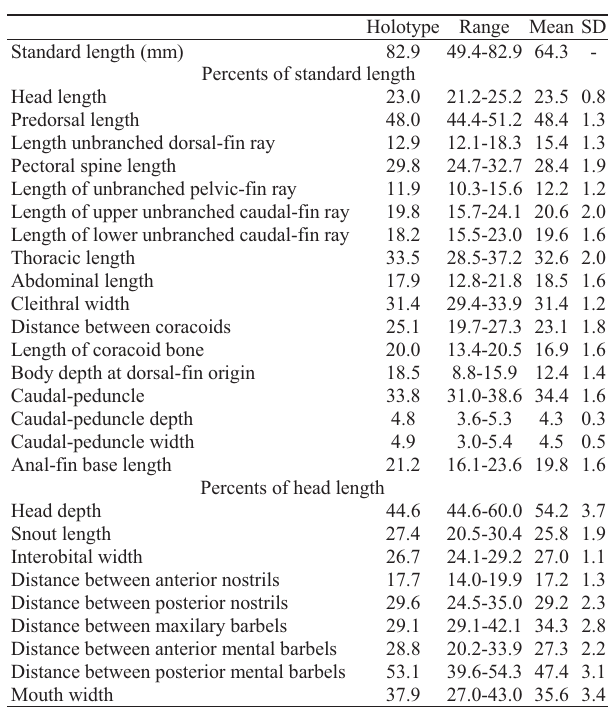
Table 1. Morfometric data of holotype and paratypes (n = 55, including the holotype) for Bunocephalus erondinae . SD = Standard deviation.